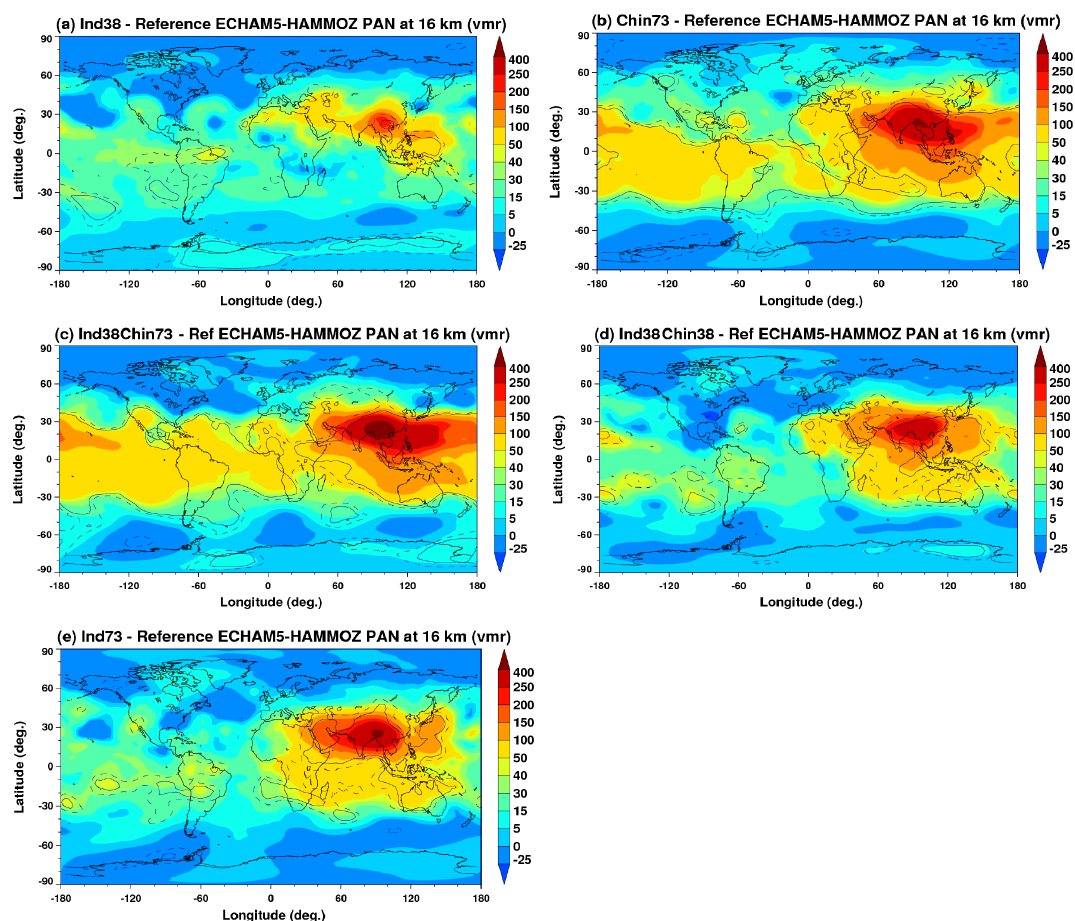
Figure 6. Change in ECHAM5-HAMMOZ PAN at 16km inppt, as obtained from (a) Ind38, (b) Chin73, (c) Ind38Chin73, (d) Ind38Chin38 and (e) Ind73 simulations. Solid black line indicates the 95% Student’s t test confidence interval while the dashed line indicates 90% confidence